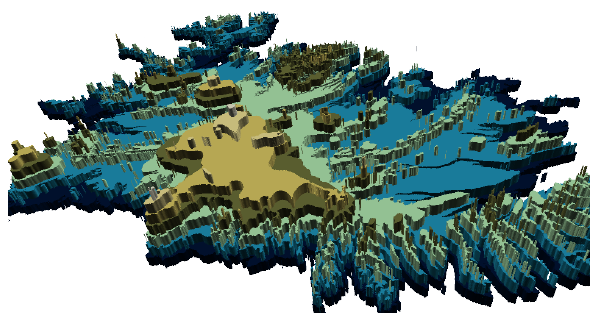
Figure 14. Rendering with steps: a first plateau is defined by the iso , the others are ± kδ away.